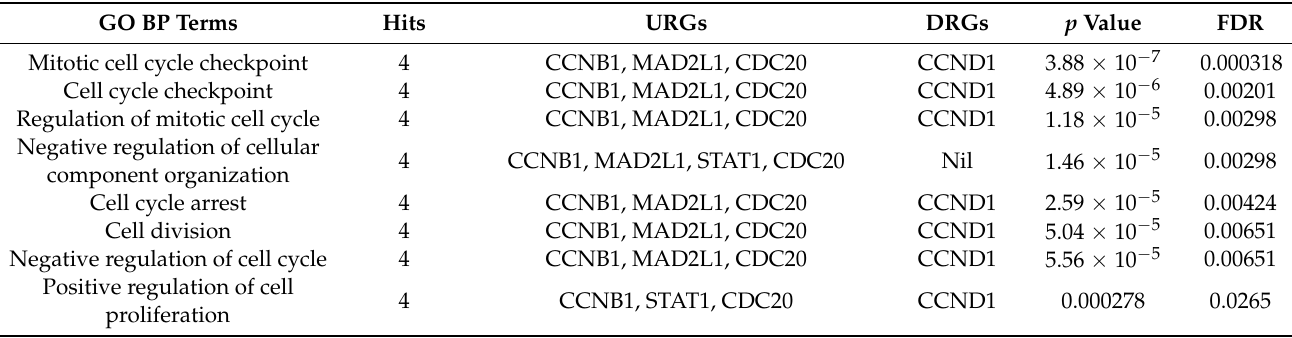
Figure 2. Hub genes from SN1. Table 1. Annotation of hub genes in GO BP .